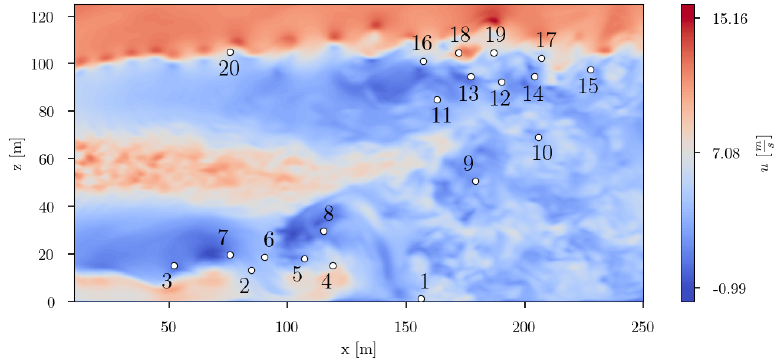
Figure 34. Final set of n s = 20 sensors obtained from